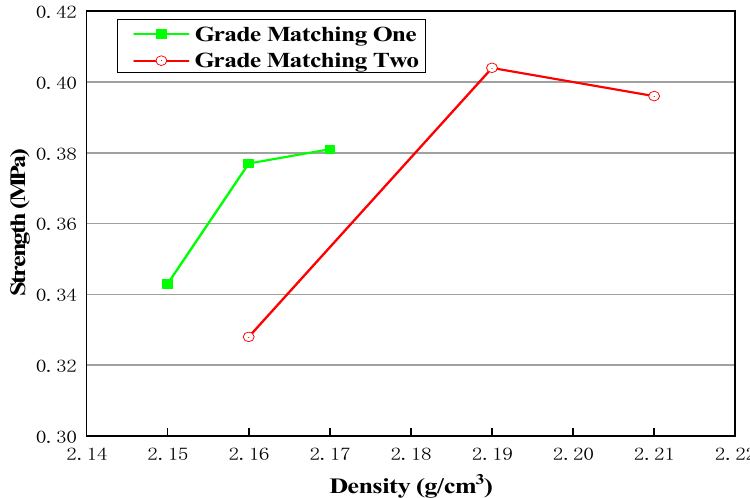
Figure 6. Relationship between density and strength of the cold recycled specimen.